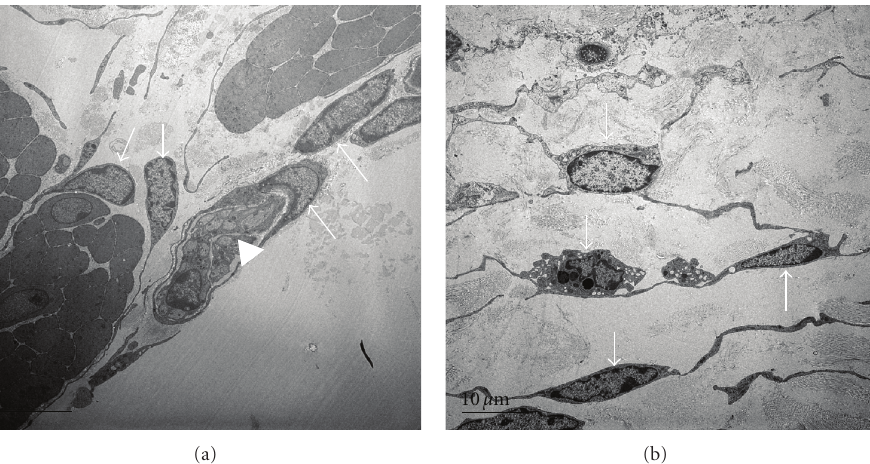
Figure 2: Electron micrographs of ICC-LC in the guinea-pig bladder. ICC-LCs made close contact with nerves and each other. Arrow: ICC, arrowhead: nerves, ×